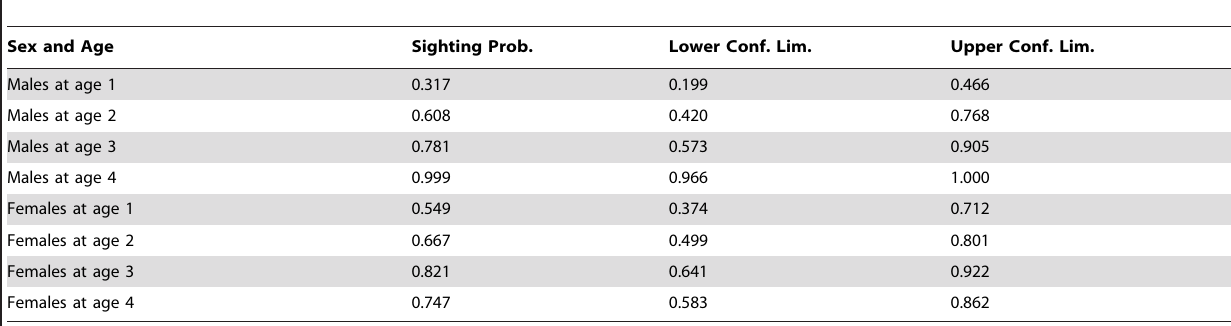
Table 2. Model-averaged sighting probabilities and confidence intervals for weaned males and female aged 1 – 4.